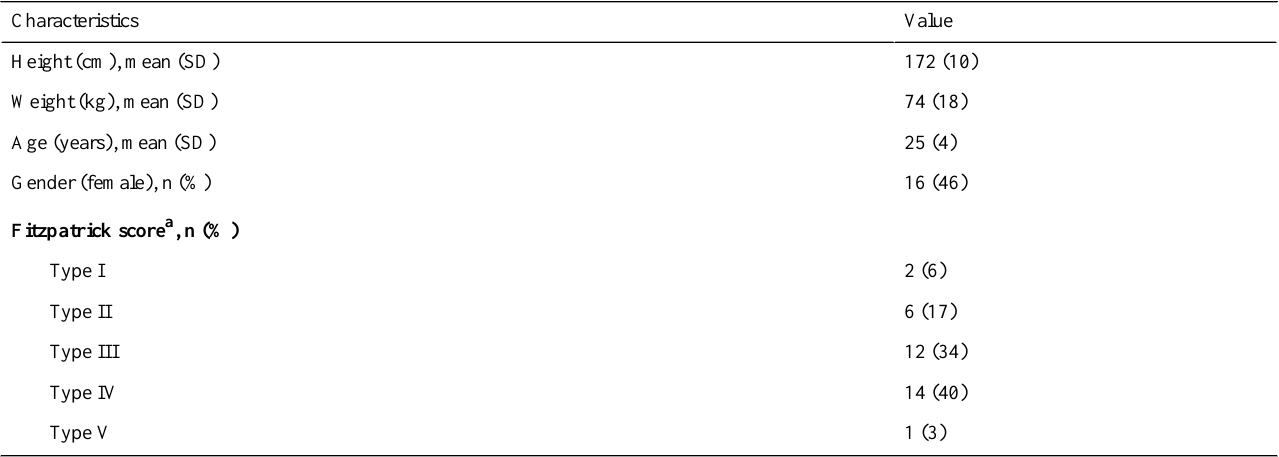
Table 1. Participant demographics (N=35). ValueCharacteristics